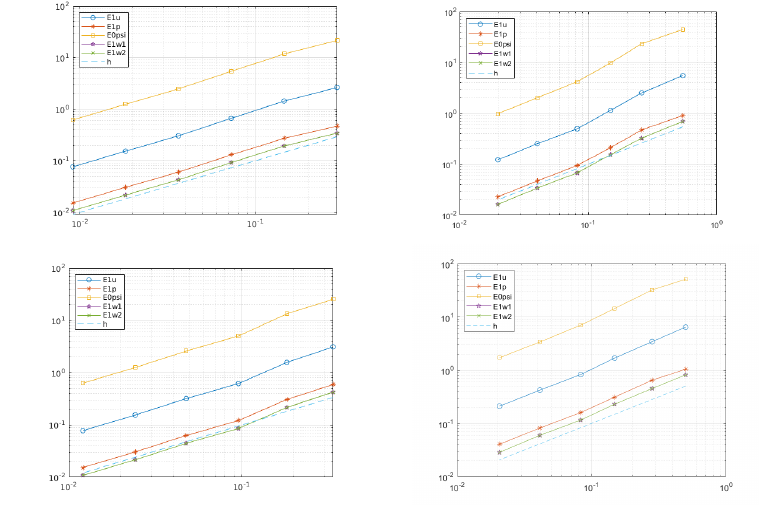
Figure 4. Computed errors for meshes N h , H h and D h in first three figures, and last one for variable κ = x + y + 10 on mesh H h